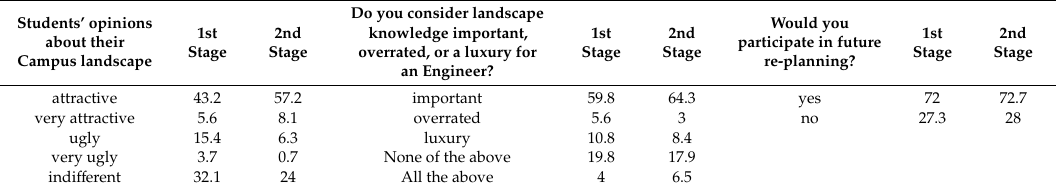
Table 5. Greek engineering students’ opinions on Campus landscape and participation in Campus re-planning (1st and 2nd research stages).